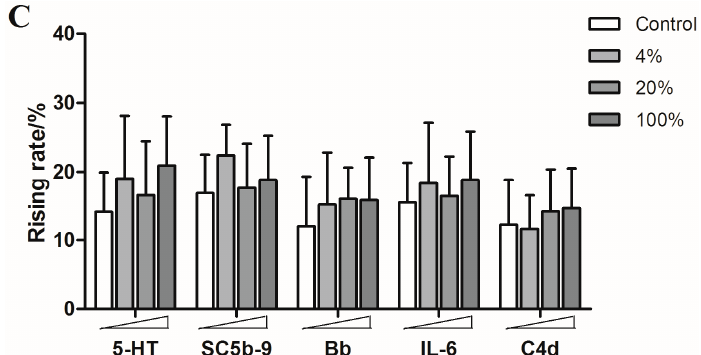
Figure 6. The rising rates of 5-HT, SC5b-9, Bb, IL-6, and C4d in animals ′ plasmas after treating with different doses of paclitaxel injection, levofloxacin injection and diammonium glycyrrhizinate injection (( A ): paclitaxel injection; ( B ): levofloxacin injection; ( C ): diammonium glycyrrhizinate injection). ** p < 0.01, *** p < 0.001 vs. control; ## p < 0.01, ### p < 0.001 vs. control; & p < 0.05, &&& p < 0.001 vs. control ( n = 10).